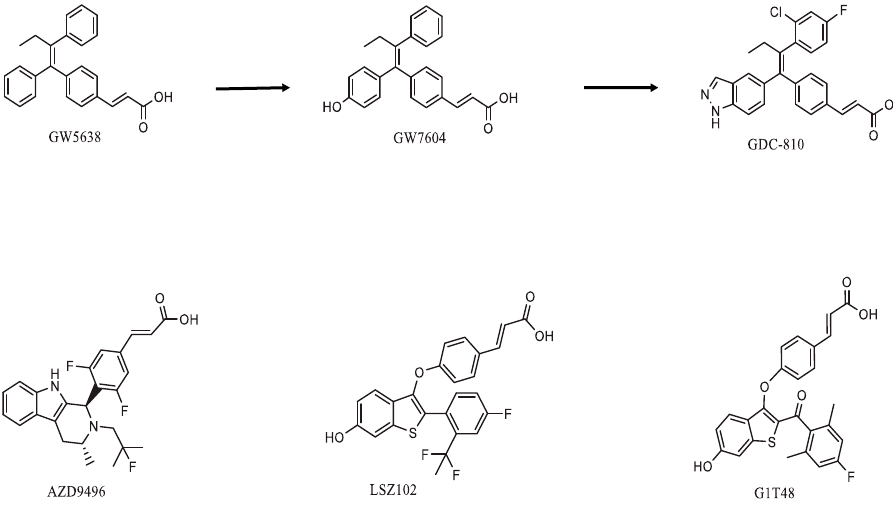
Figure 2. Structures of orally available SERDs with an acrylic acid functional group.